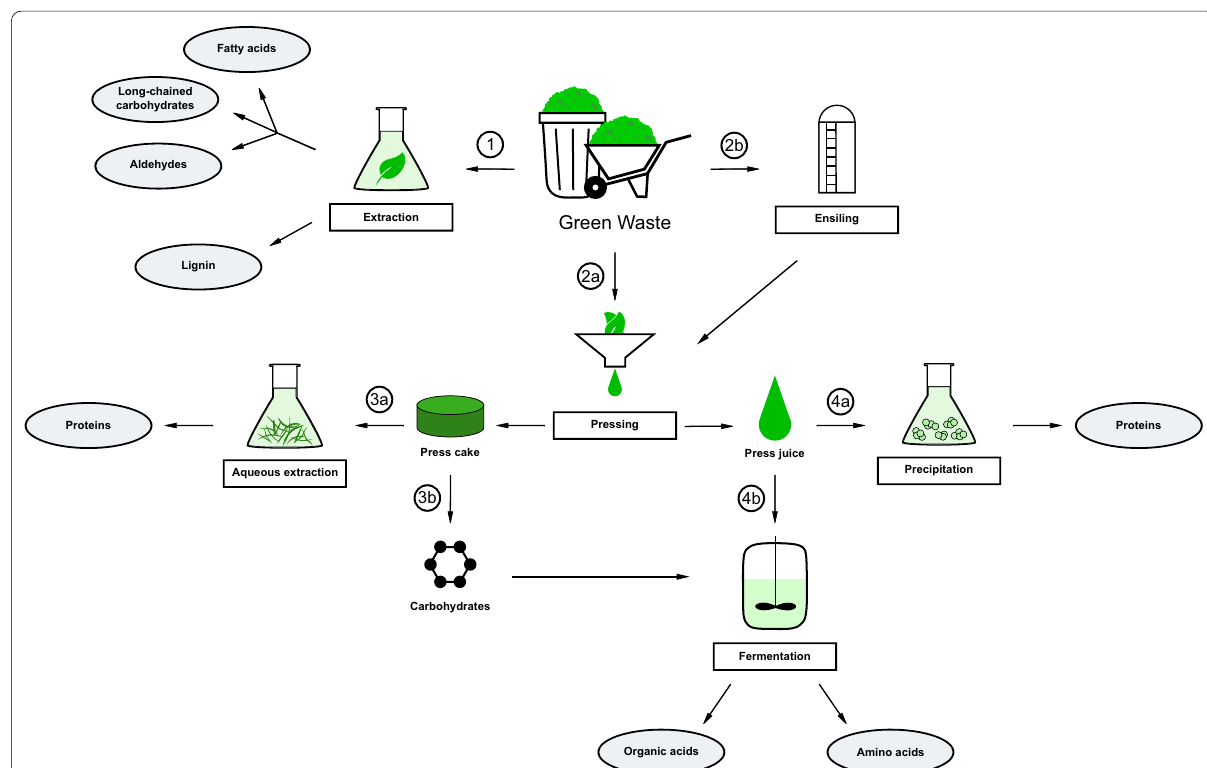
Fig. 3 Processes for the production of extracts from green waste. Products are obtained from green waste directly by extraction (1) or via pressing (2a), possibly after ensiling the biomass (2b). After pressing, proteins are obtained from aqueous extraction of the press cake (3a) and precipitation of the press juice (4a). Carbohydrates gained from the press cake (3b) are added to the press juice for fermentation